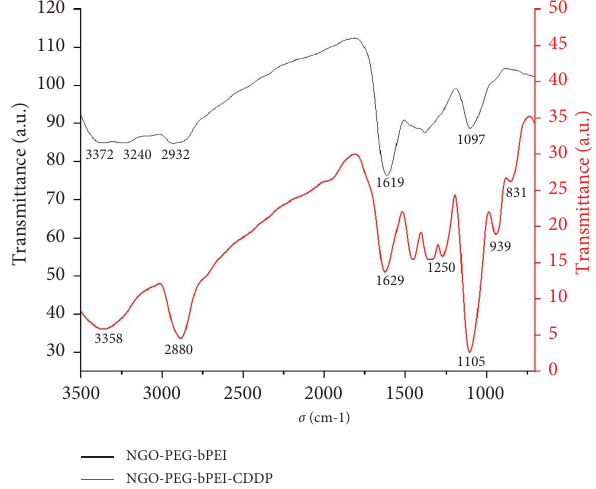
Figure 3: FTIR spectra of NGO-PEG-BPEI and NGO-PEG-BPEI- CDDP. Te absorption peaks of NGO-PEG-BPEI are 3372cm − 1 , 3240cm − 1 , 2932cm − 1 , 1619 cm − 1 , and 1097cm − 1 ; the absorption peaks of NGO-PEG-BPEI-CDDP are 3358cm − 1 , 2880cm − 1 ,